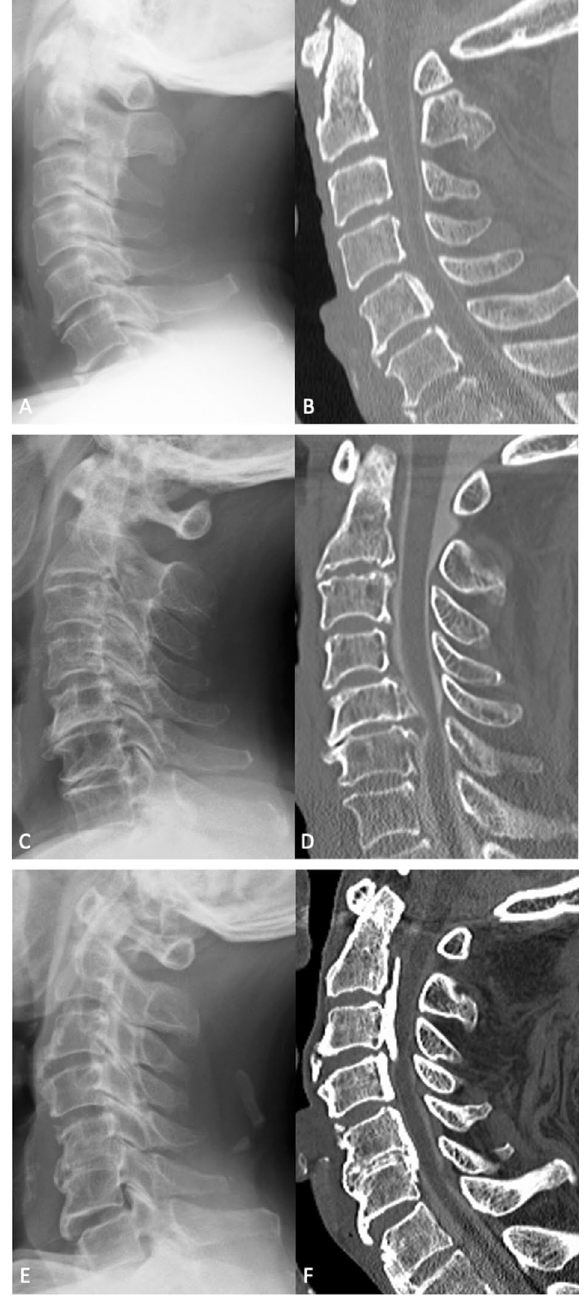
Figure 1. Representative radiographs used in the test dataset and their corresponding computed tomography (CT) images, for the reference of ossification of the posterior longitudinal ligament (OPLL). ( A ) Lateral radiograph of a patient with OPLL, which all spine surgeons misdiagnosed as cervical spondylosis, but the convolutional neural network (CNN) diagnosed correctly. ( B ) A CT scan of the same patient from panel A showing segmental OPLL in C5 and C6. ( C ) Lateral radiograph of a patient with OPLL, which all spine surgeons and the CNN misdiagnosed as cervical spondylosis. ( D ) A CT scan of the same patient from panel ( C ) showing segmental OPLL in C5 and C6. ( E ) Lateral radiograph of a patient with OPLL, which the CNN misdiagnosed as cervical spondylosis, but all spine surgeons diagnosed correctly. ( F ) A CT scan of the same patient from panel ( E ) showing a mixed type of OPLL in